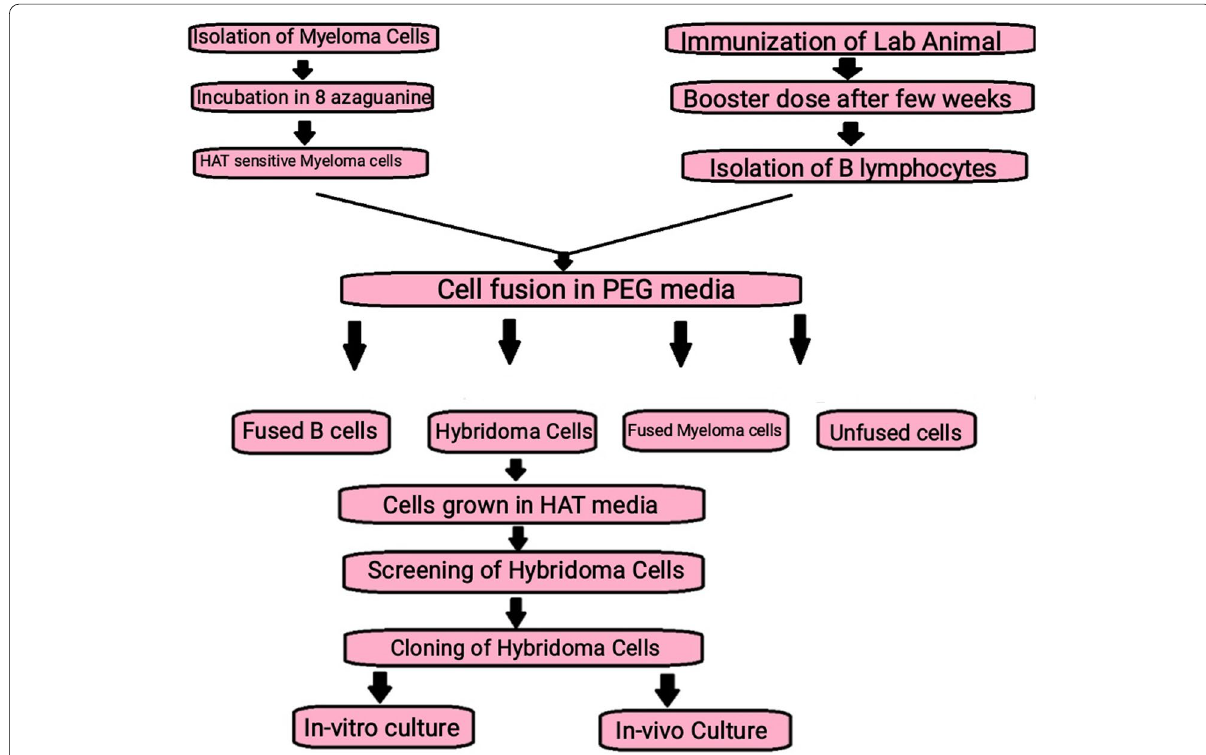
Fig. 3 Flow chart showing the methodology of hybridoma technology